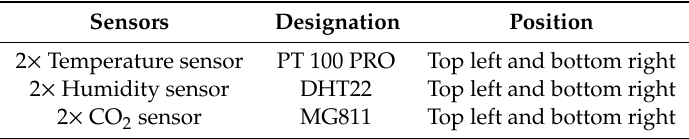
Table 2. Atmospheric enclosure sensors.